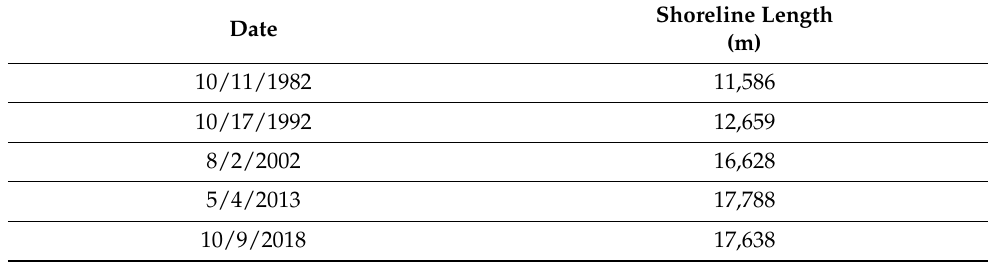
Table 7. Shoreline length data of Segment D.